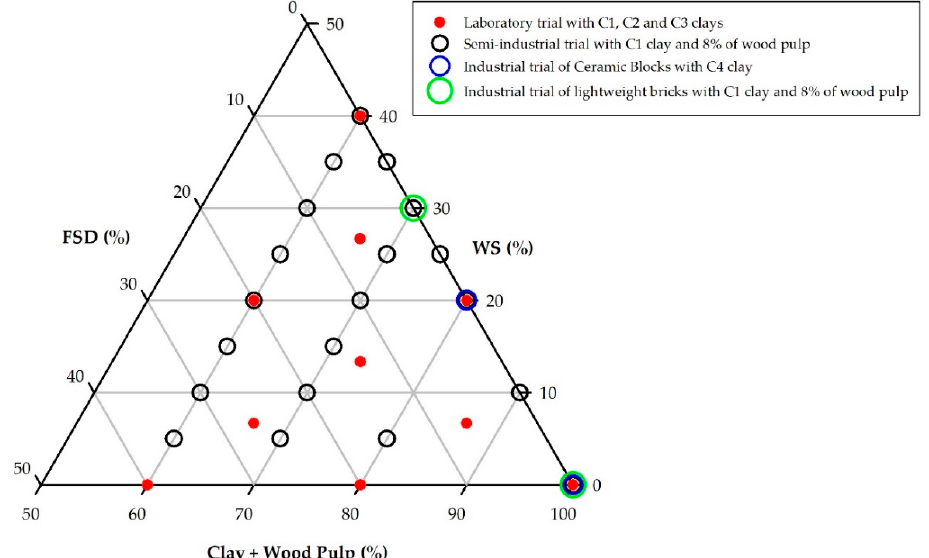
Figure 2. Location of the mixtures in the ternary diagram of raw material components in the ceramic product trials.